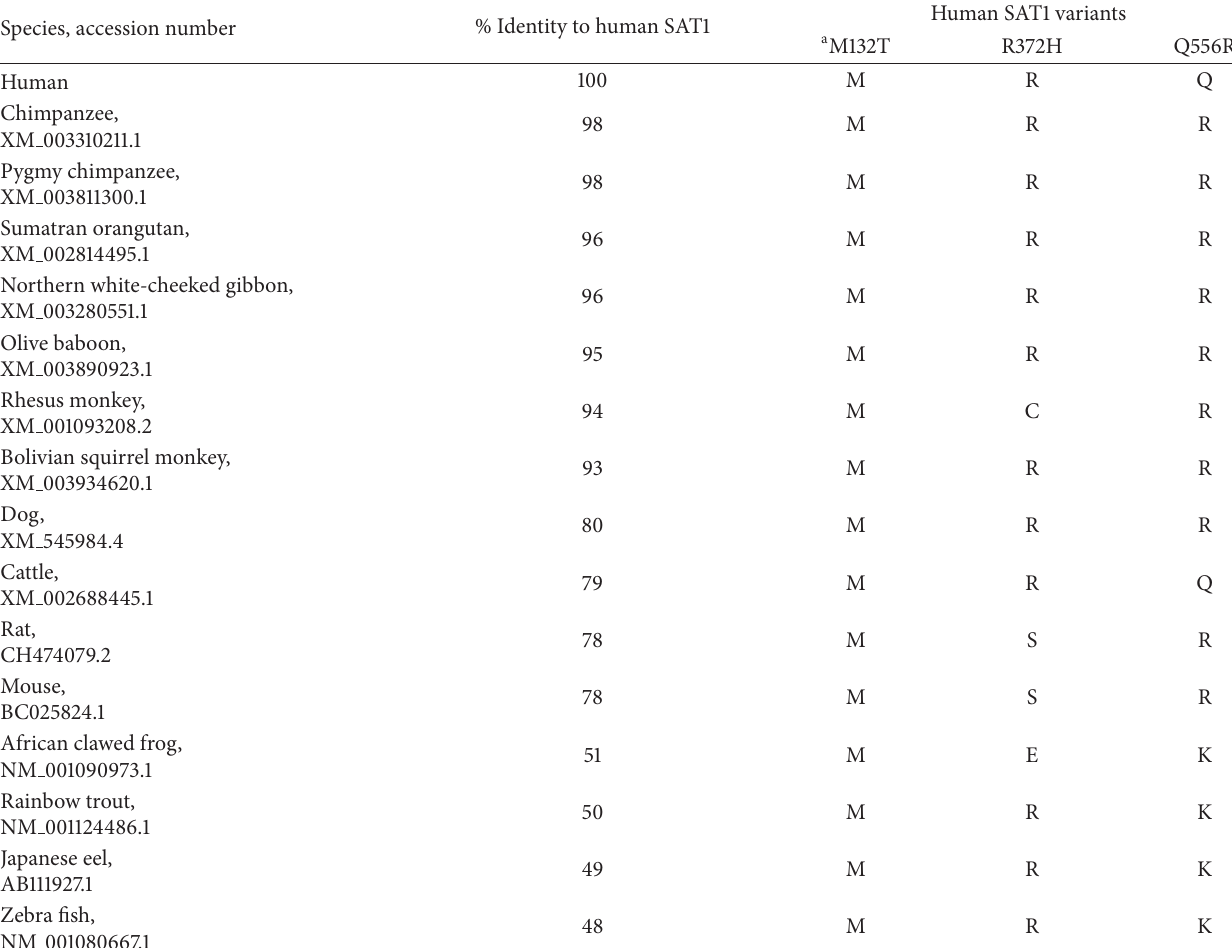
Table 4: Alignment of human SAT1 amino acid variants across species.